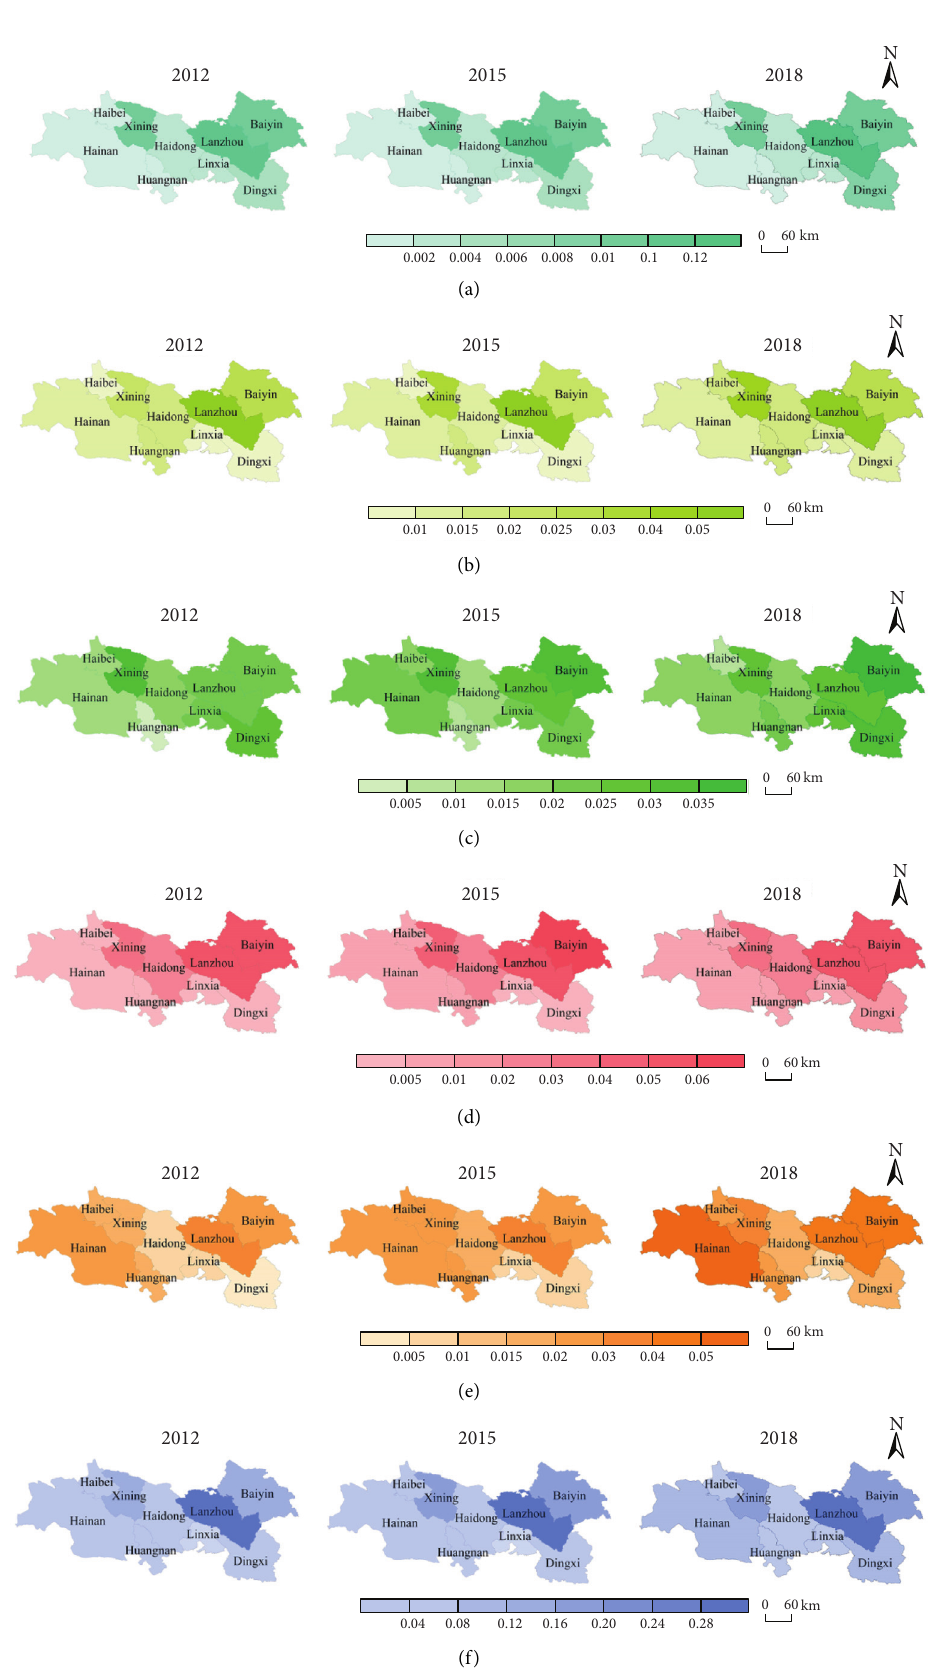
Figure 5: Spatial differentiation of the high-quality development level in Lanzhou-Xining urban